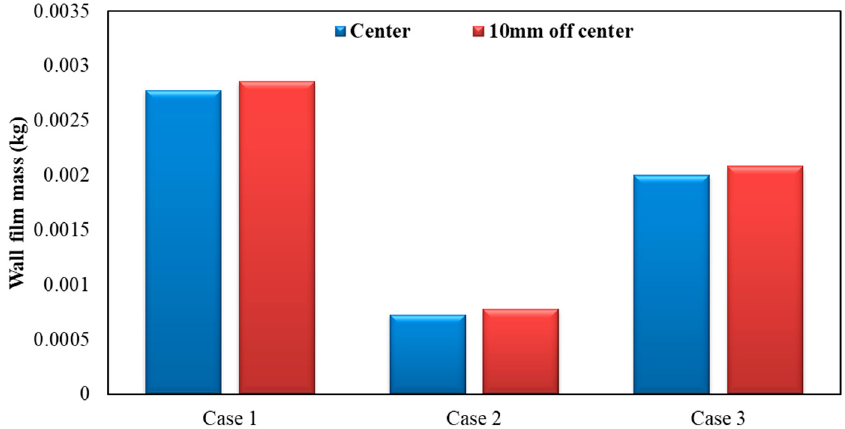
Figure 17. In fl uence of di ff erent nozzle positions on wall fi lm mass. Figure 17. Influence of different nozzle positions on wall film mass.